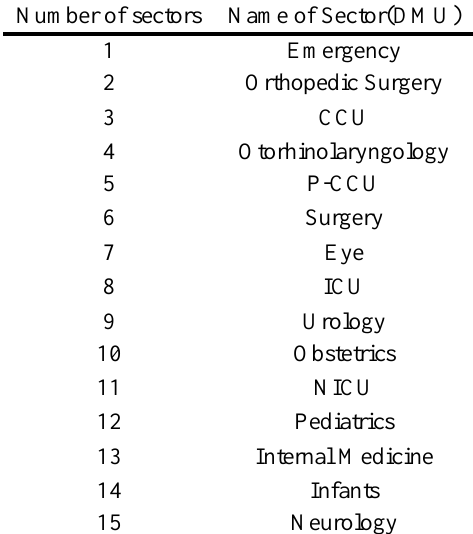
Table 2. Hospital sectors in